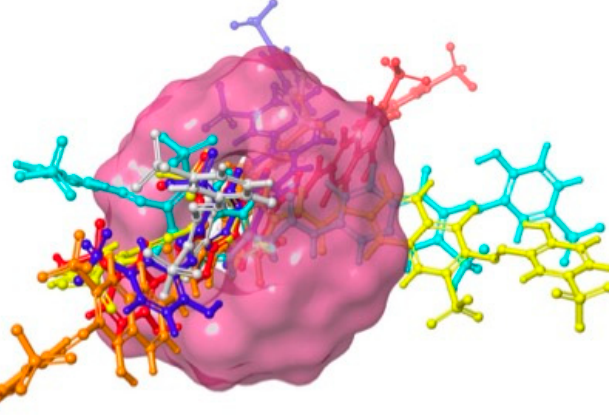
Figure 9. A summary of the results by using computational methods. The β -CD is displayed as a pink surface while Direct Red 83:1 is represented with ball and stick models. Color scheme: red, charge = − 3; orange, charge = − 4; yellow, charge = − 5; cyan, charge = − 6; blue, charge = − 7; grey, charge = − 8.